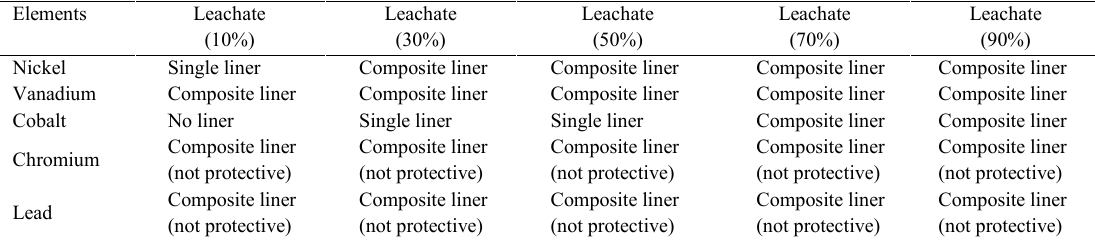
Table 8: Final liner scenarios for different leachate concentrations and elements